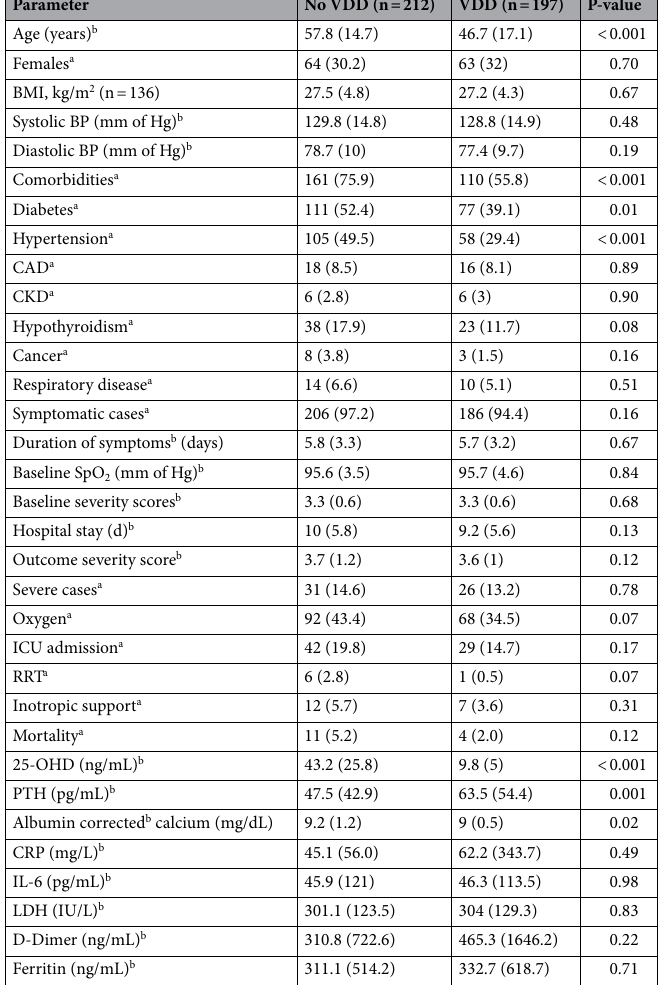
Table 1. Comparison of hospitalized COVID-19 patients with or without vitamin D deficiency (VDD), data presented as number (percentage) for categorical a and mean (SD) for continuous variables b